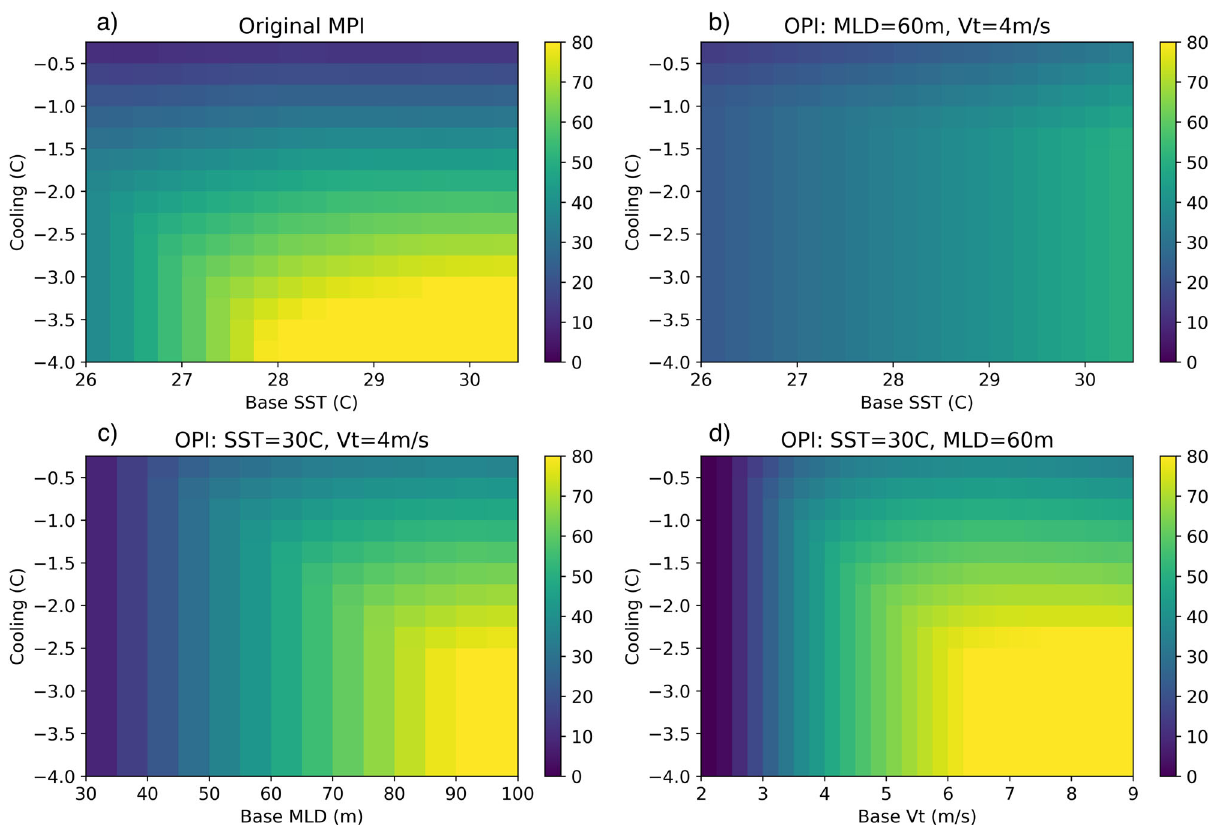
Fig. 2 Weakening of potential intensity after arti fi cial cooling is introduced, as functions of degree of arti fi cial cooling, SST, MLD, and Vt. a Increase in P fi cial cooling, b increase in P fi cial cooling, min predicted by MPI as a function of initial SST and arti min predicted by OPI as a function of initial SST and arti c increase in P min predicted by OPI as a function of initial MLD and arti fi cial cooling, and d increase in P min predicted by OPI as a function of translation speed and arti fi cial cooling.